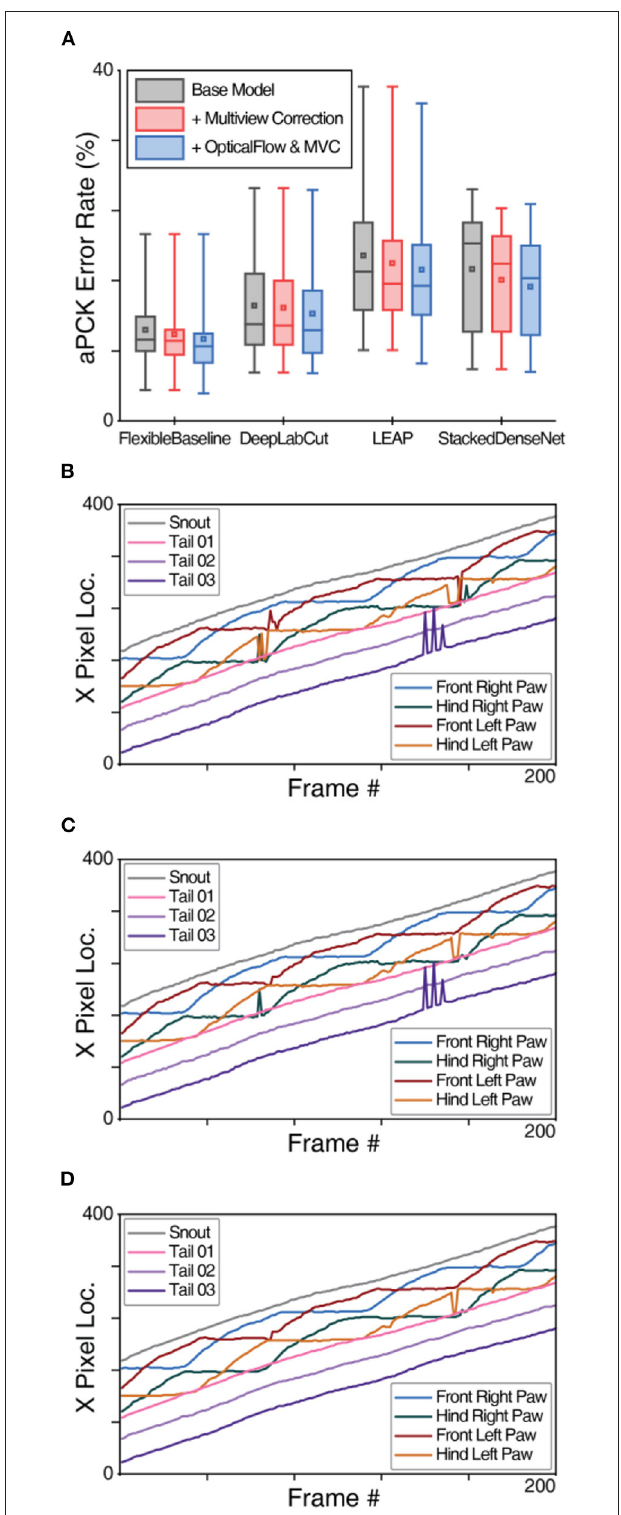
FIGURE 5 | Multiview paw correction algorithm evaluation of OptiFlex. (A) Box plot of test set prediction aPCK error rates of models with and without multi-view correction on paws, grouped by base model. Box plot specified